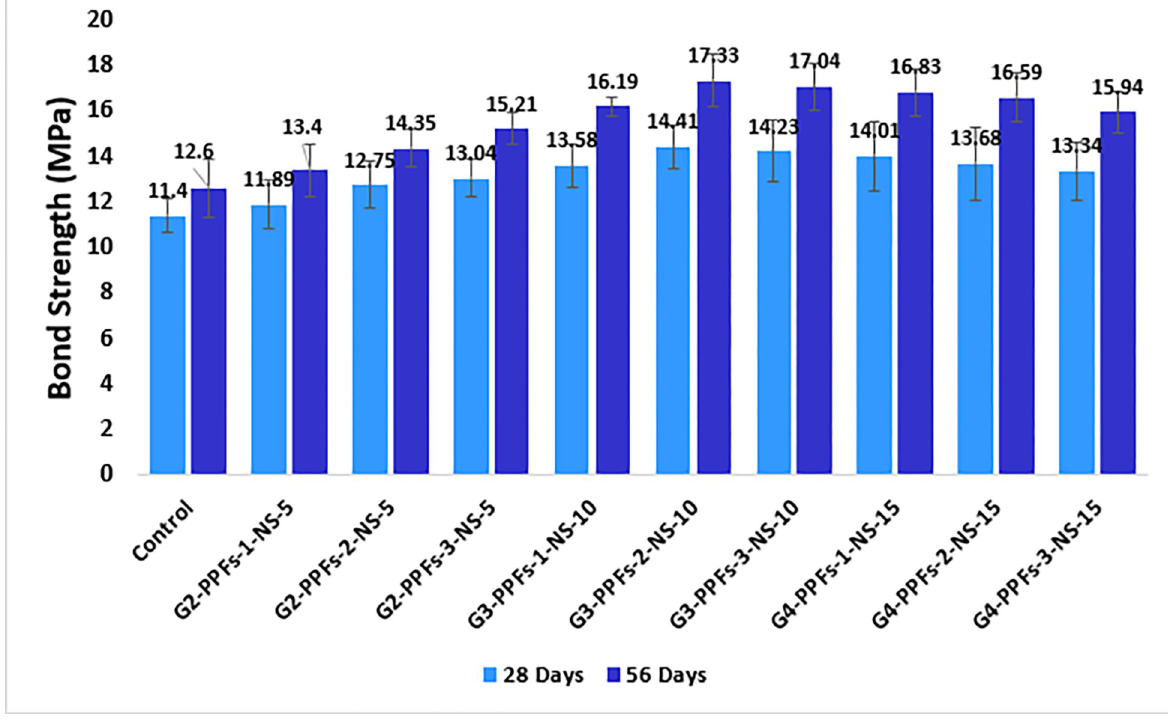
Fig 11. Bond strength of UHS-GPC at 28 and 56